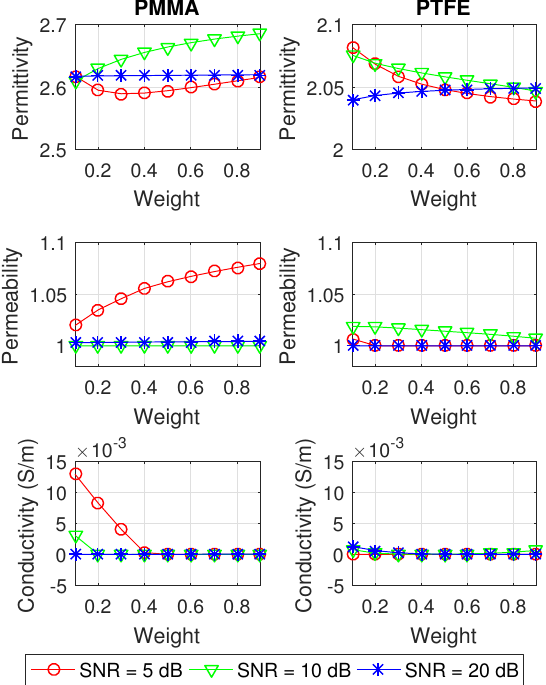
Figure 15. The extracted properties of the theoretical samples, for different SNR and weights w . The simulation for PMMA are on the ( left ), whereas for PTFE are on the ( right